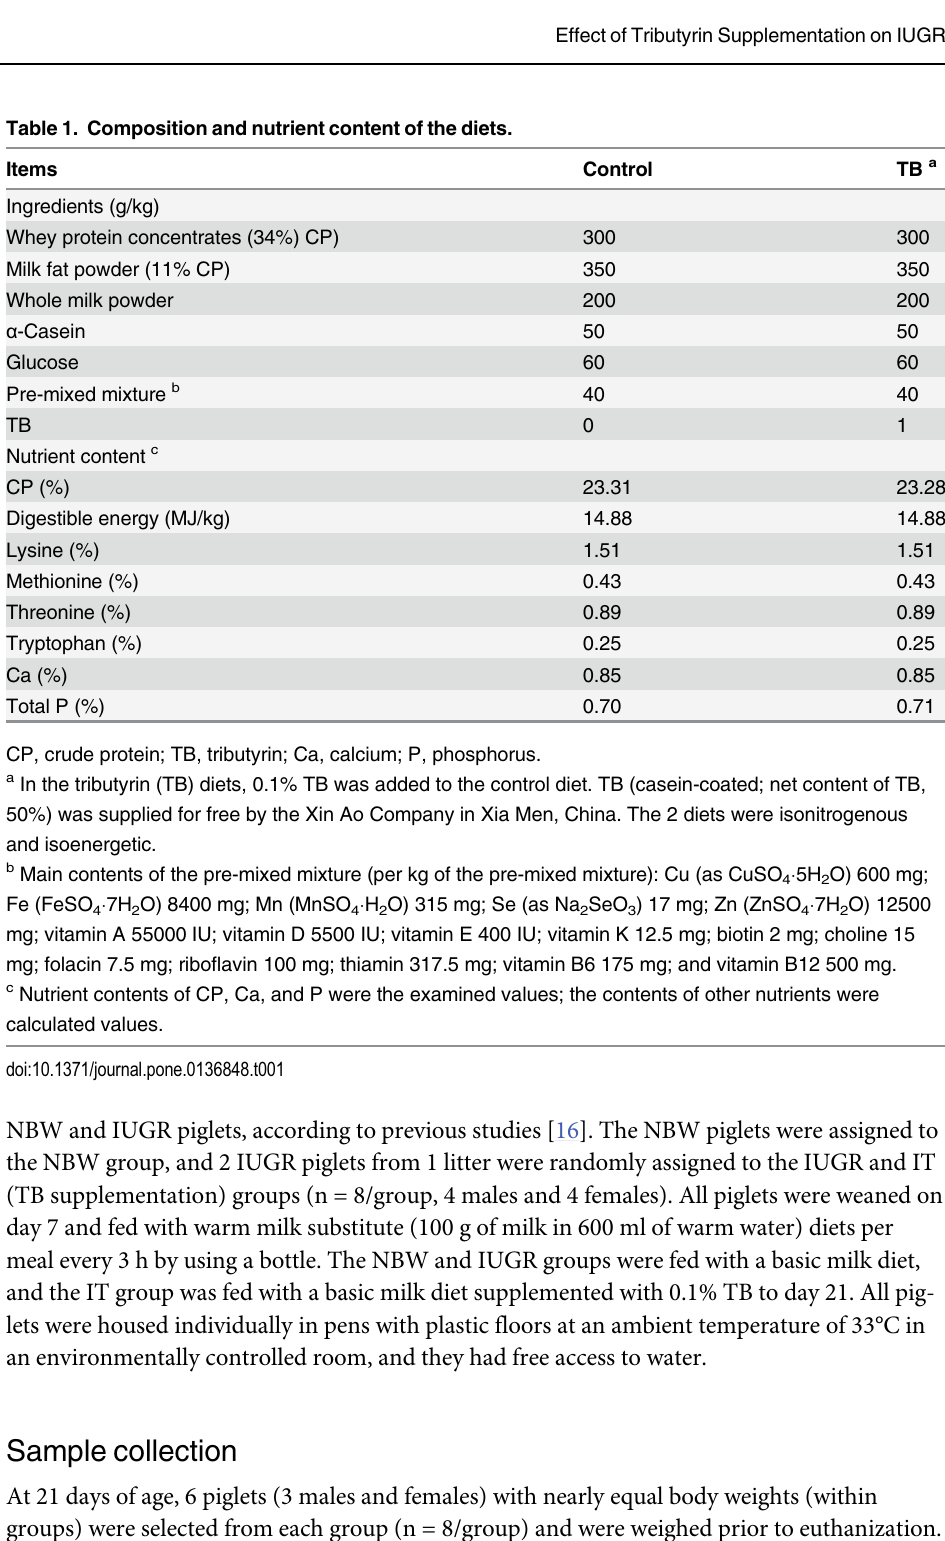
Table 1. Composition and nutrient content of the diets. Items Control TB a Ingredients (g/kg) Whey protein concentrates (34%) CP) 300 300 Milk fat powder (11% CP) 350 350 Whole milk powder Glucose